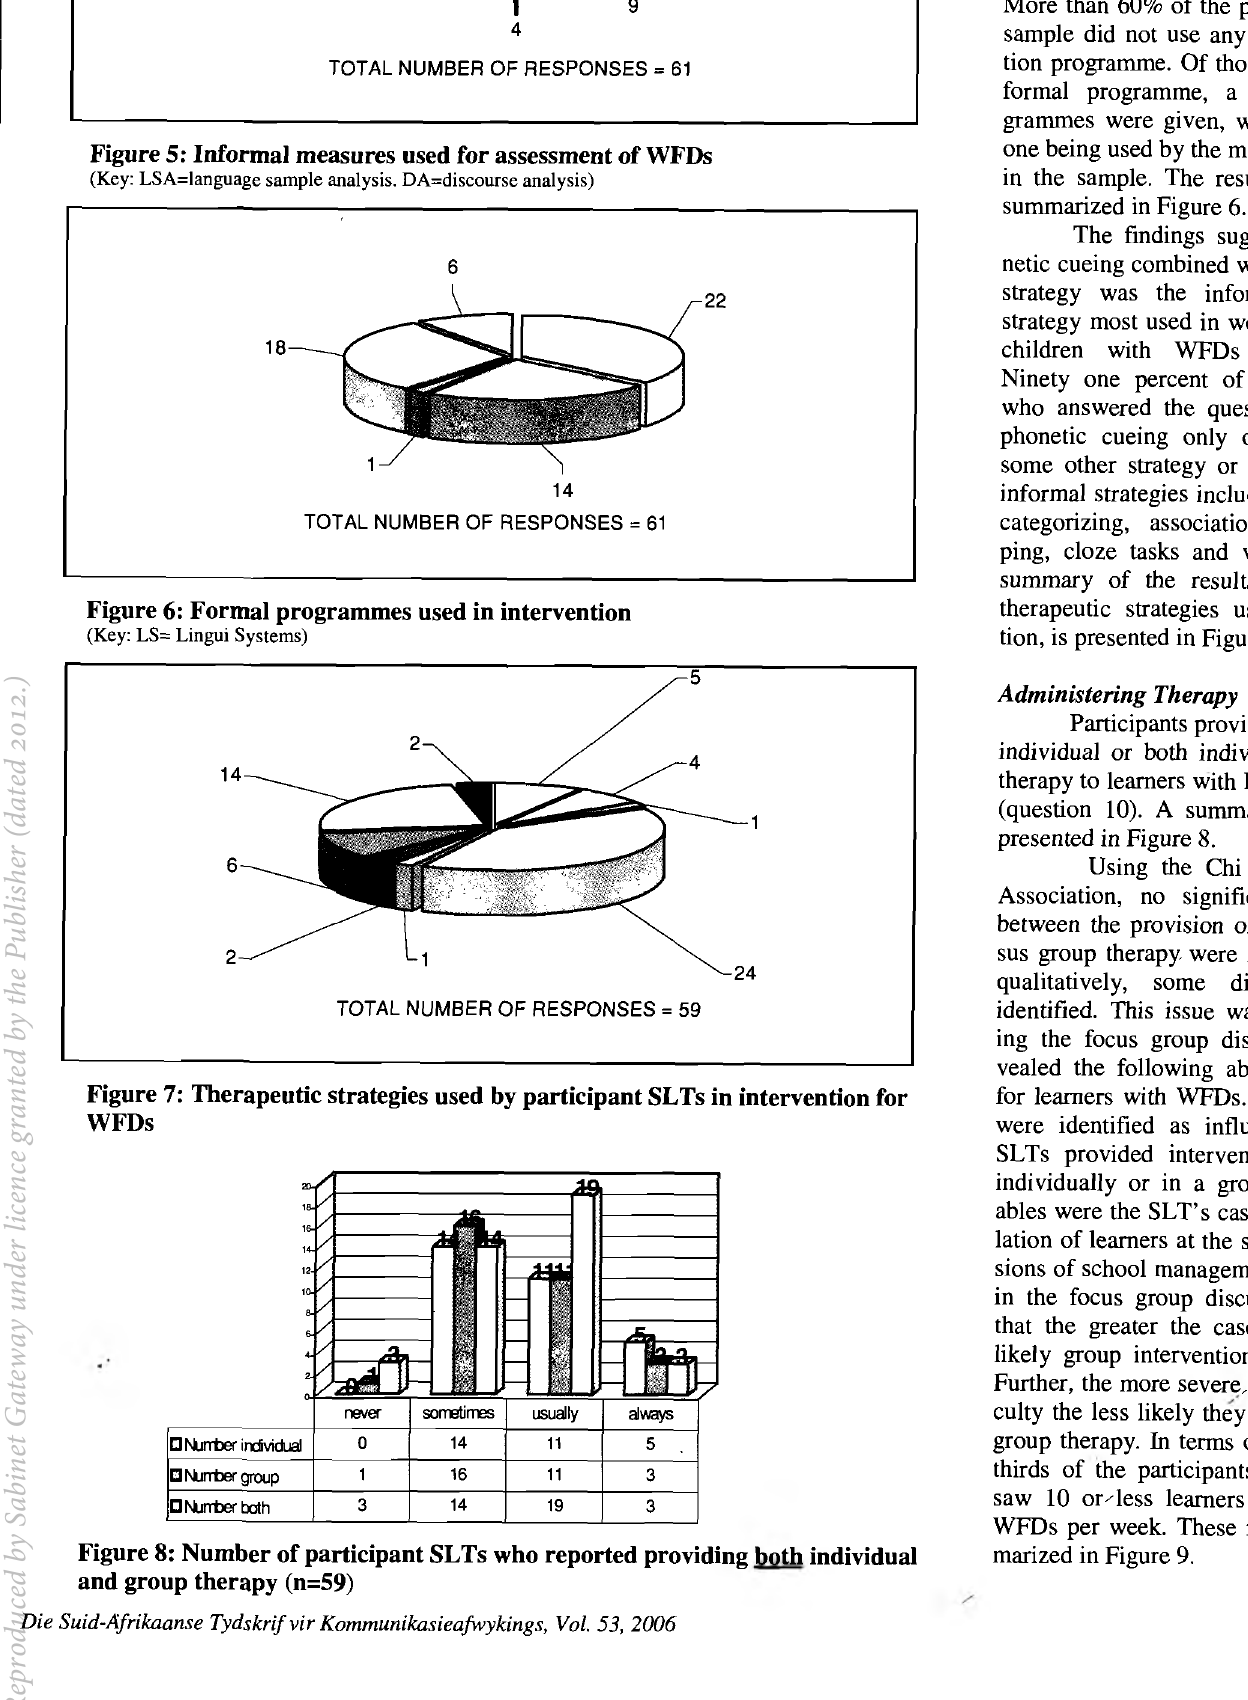
Figure 8: Number of participant SLTs who reported providing both individual and group therapy